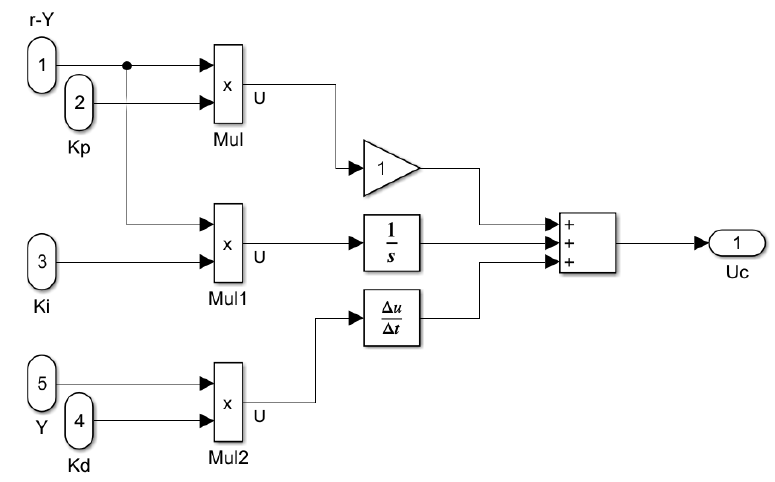
Figure 9. Controller block.